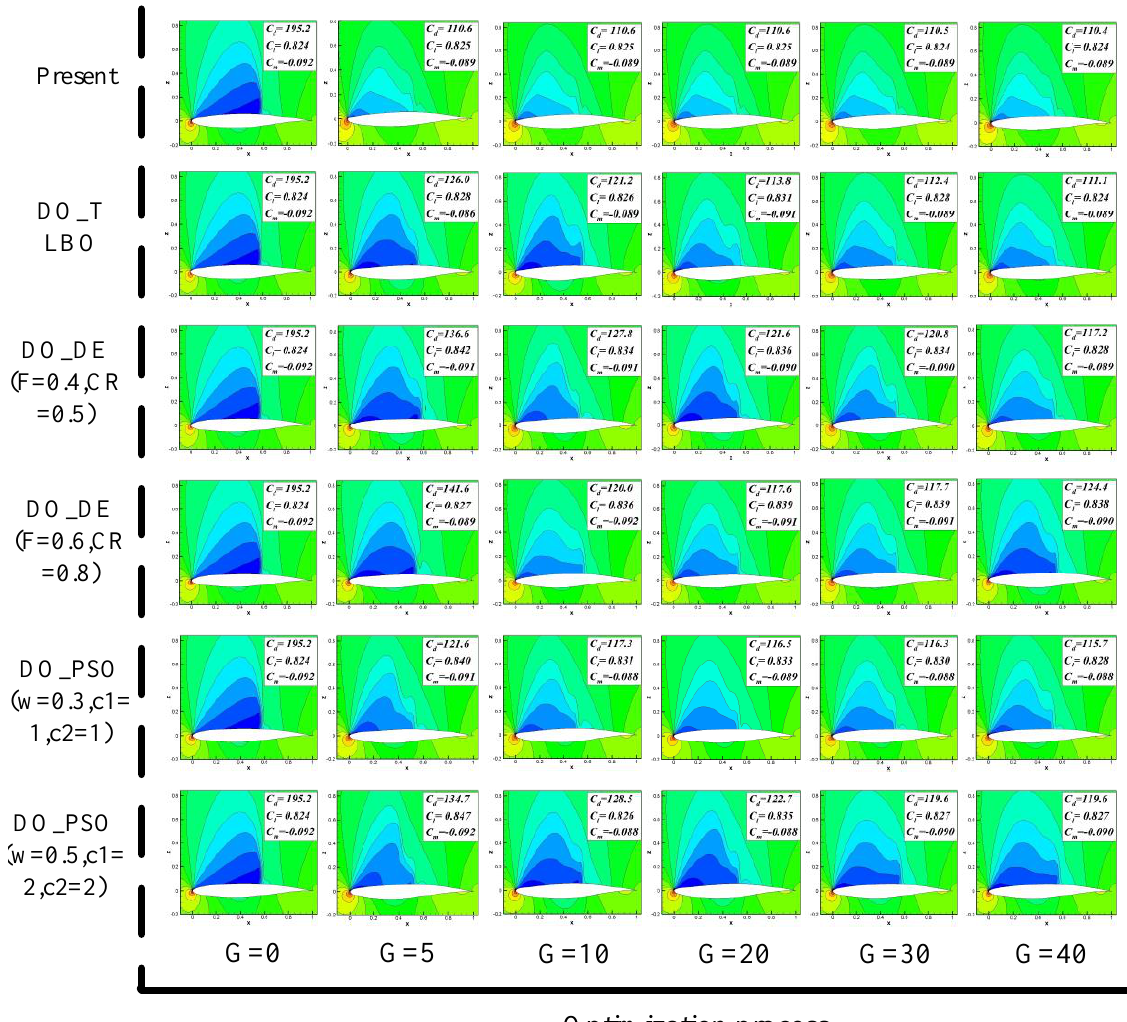
Figure 7. C p Contour convergence with the optimization process.